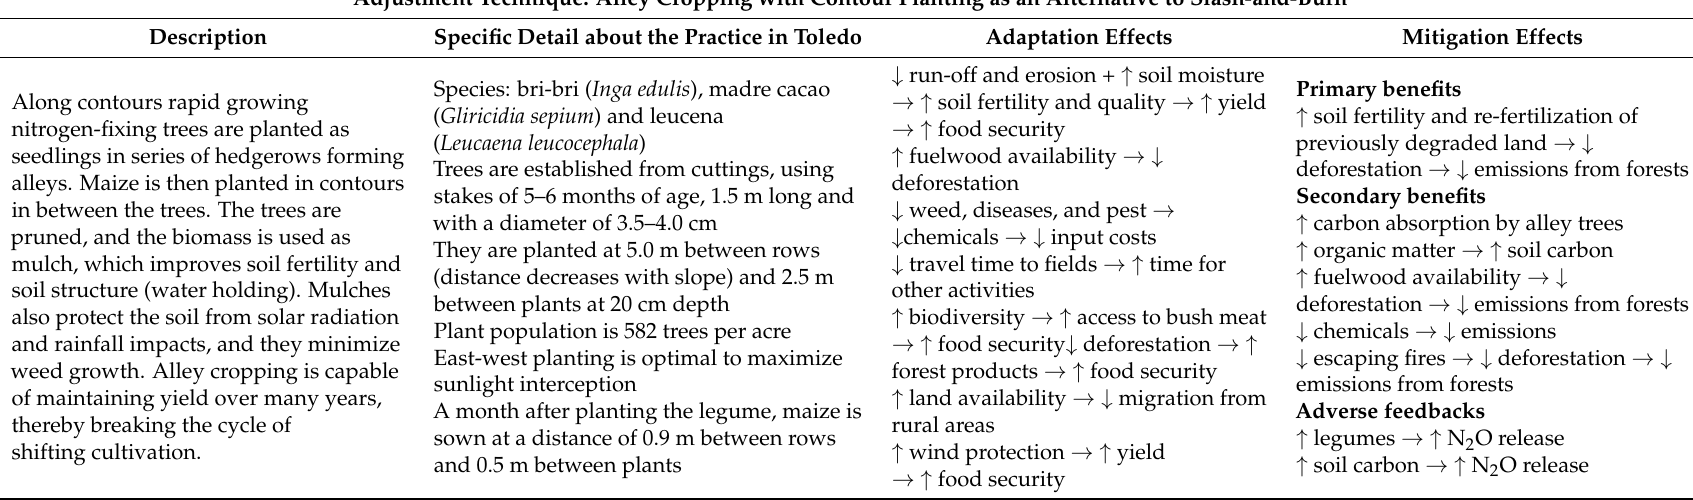
Table 2. The suggested adjustment to enhance Climate-smart agriculture (CSA) in maize production among smallholders in Maya villages of Toledo district, southern Belize. (Legend: → cause, ↓ decrease, ↑ increase). References used in locating the effects: [57–62]. Adjustment Technique: Alley Cropping with Contour Planting as an Alternative to